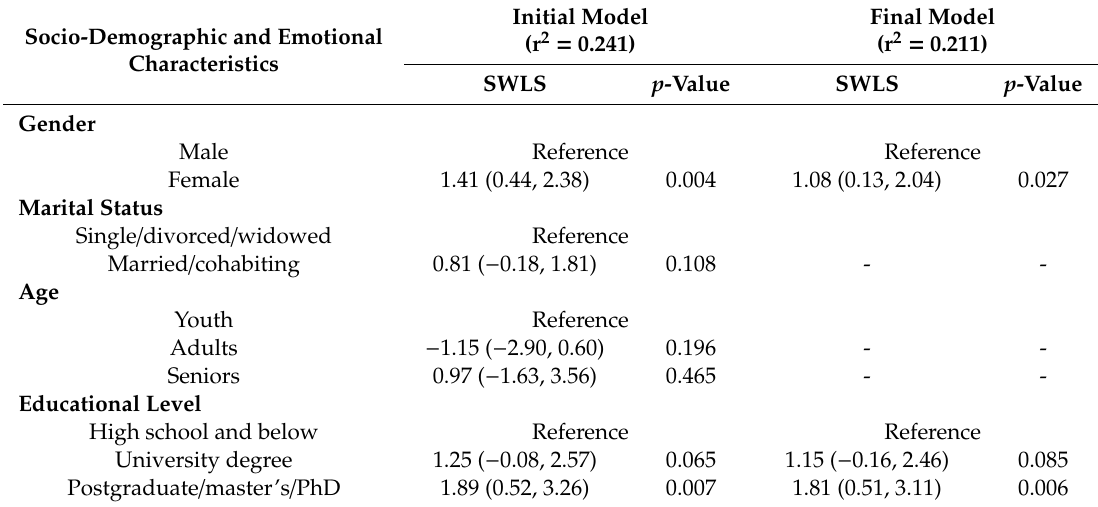
Table 3. Regression coe ffi cients for Satisfaction with Life Scale (SWLS) as an outcome with socio-demographic and emotional variables as predictors, from univariate multiple linear